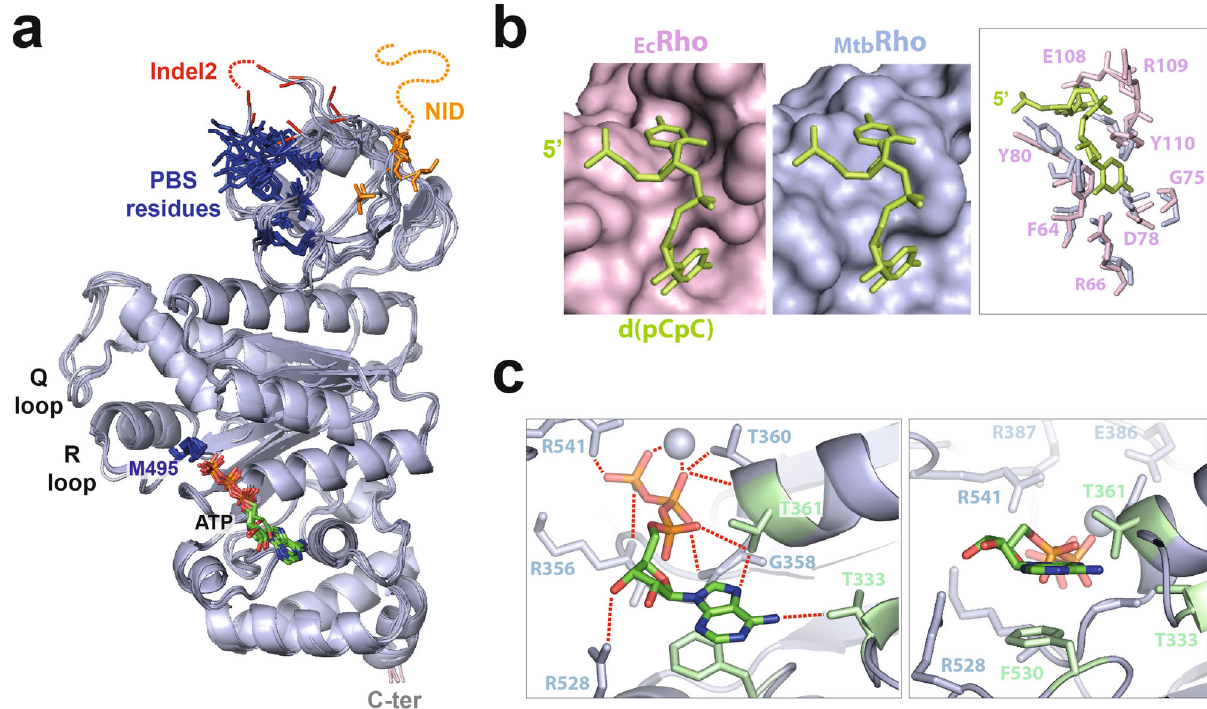
Fig. 2 Organization of the ligands binding network in Mtb Rho. a Superposition of the six Mtb Rho protomers with the main RNA and ATP binding motifs highlighted. ATP ligands are shown as in Fig. 1d with closeby Met495 side-chains in dark blue. Resolved residues equivalent to the PBS residues of Ec Rho are also shown in dark blue. b Comparison of the PBS pockets of Ec Rho and Mtb Rho. A dC 2 ligand (in green) has been modeled on Mtb Rho upon structural alignment with Ec Rho (PDB 1PV4). c Closeup views of the ATPase pocket at the best resolved interface (C/D) of Mtb Rho showing the network of interaction with the ATP ligand and catalytic Mg 2 + ion